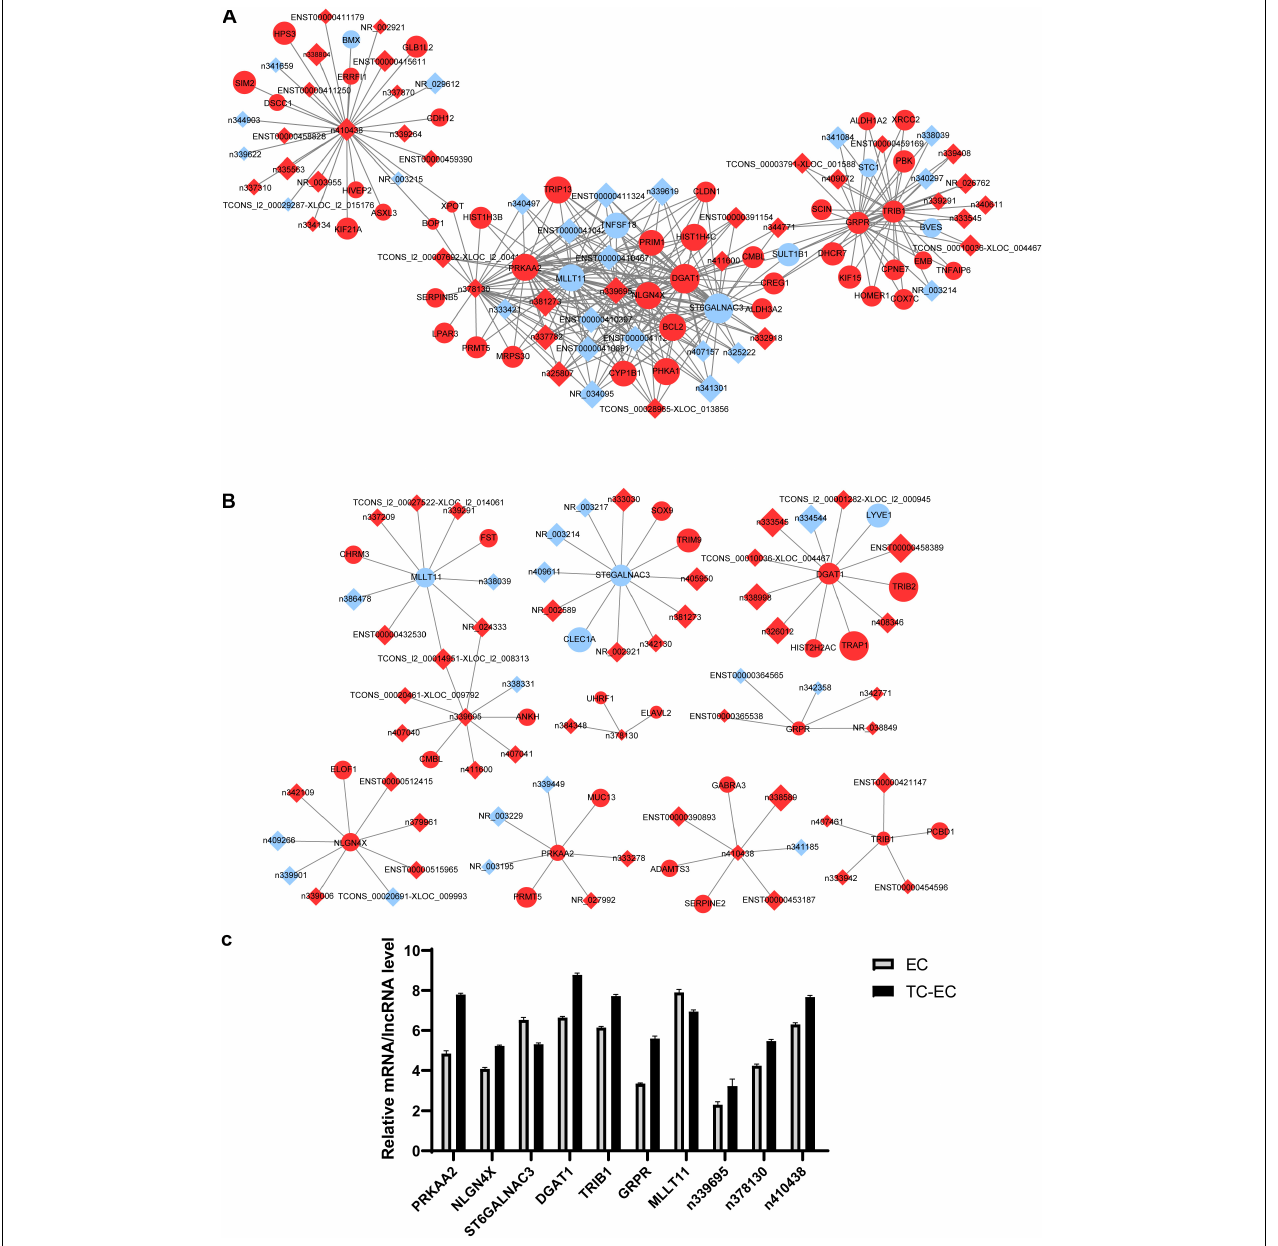
FIGURE 5 | mRNA–lncRNA co-expression network analysis of key mRNAs or lncRNAs in EC alone (A) and TC–EC model (B) . In the network, the circle represents mRNA, the rhombic represents lncRNA. Red represents the upregulated mRNAs/lncRNAs, blue represents the downregulated mRNAs/lncRNAs. Those mRNA/lncRNAs without interaction relationships were not displayed in the network. (C) Expression level of the top 10 differential mRNAs or lncRNAs between the TC–EC model and EC according to the mRNA–lncRNA co-expression network